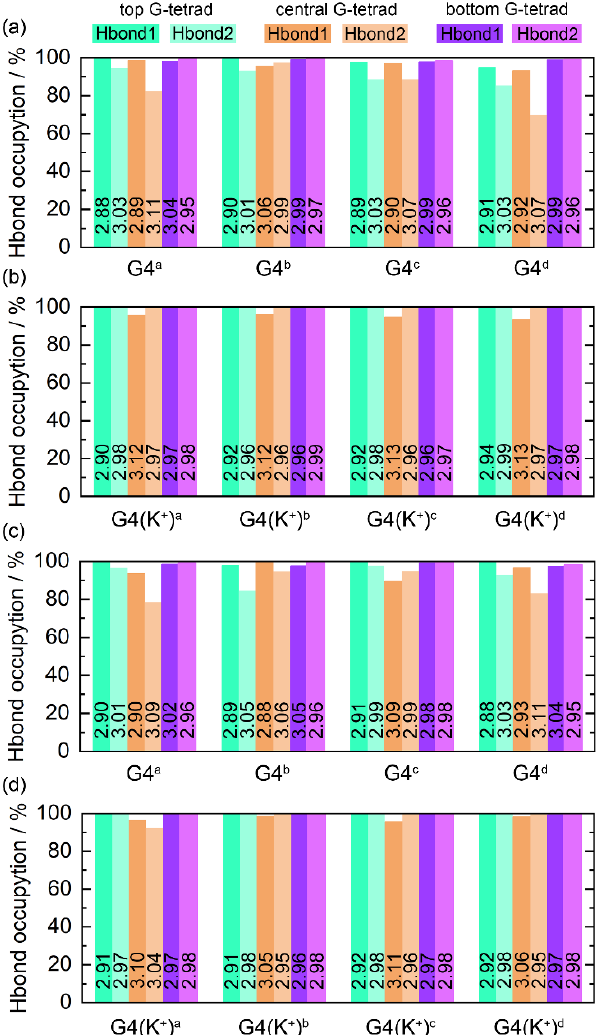
Figure 6. Hoogsteen hydrogen-bond analysis. The hydrogen bonds of N1−H1···O6 and N2−H21···N7 Hoogsteen hydrogen-bond analysis. The hydrogen bonds of N1 − H1 ··· O6 and are denoted as Hbond1 and Hbond2, respectively. The number on each column corresponds to the N2 − H21 ··· N7 are denoted as Hbond1 and Hbond2, respectively. The number on each column G-tetrad layer-averaged hydrogen-bond length. corresponds to the G-tetrad layer-averaged hydrogen-bond